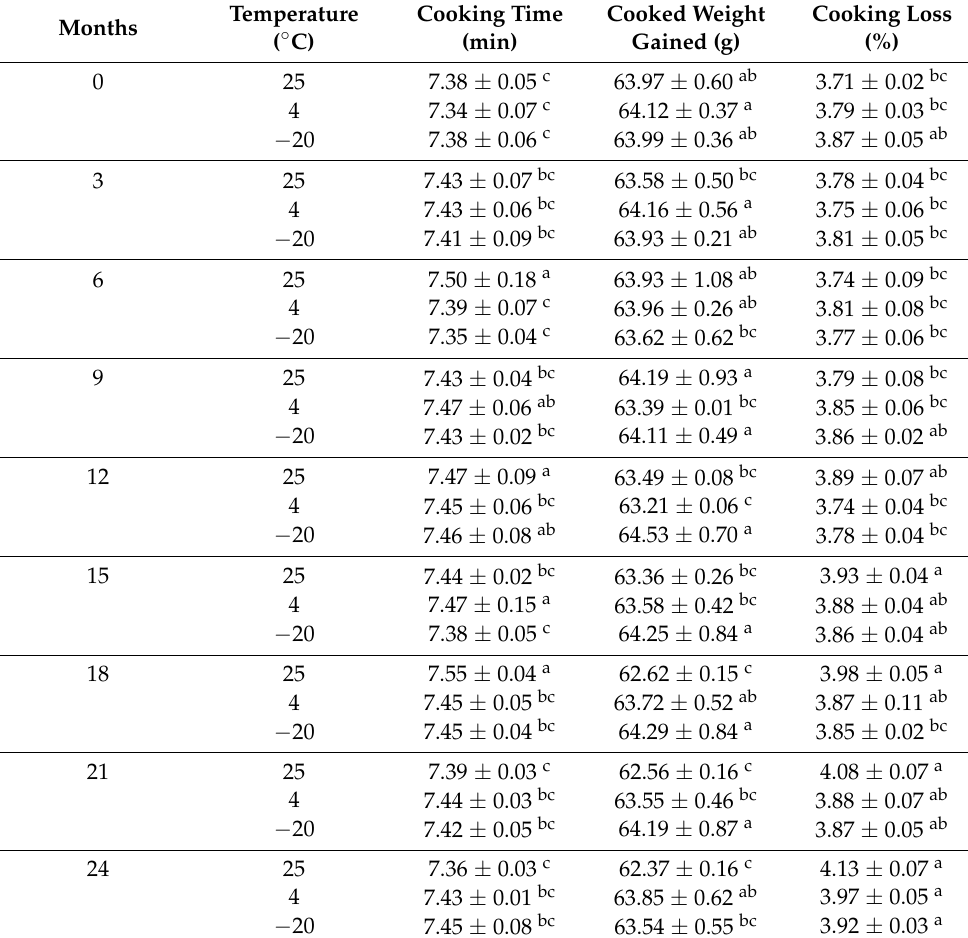
Table 1. Cooking quality characteristics of wheat noodles fortified with isomaltodextrin during different storage periods and